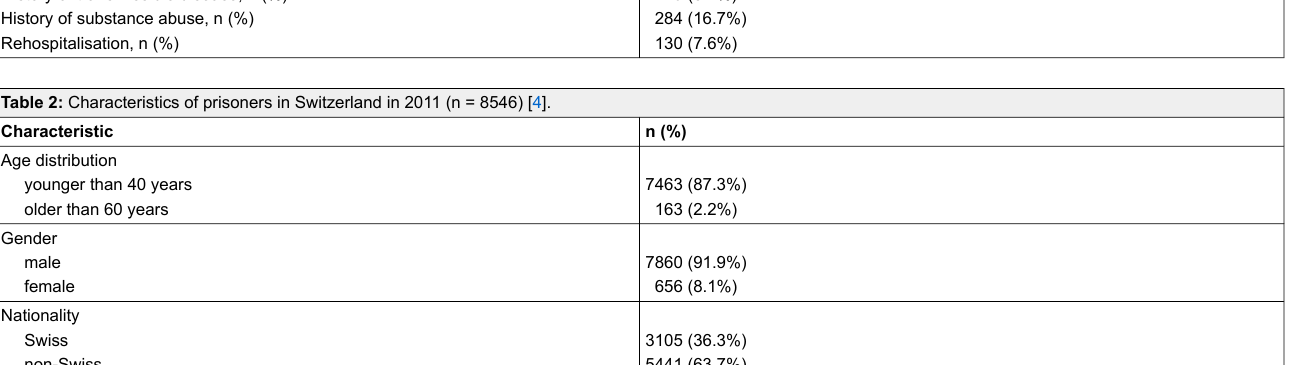
Table 2: Characteristics of prisoners in Switzerland in 2011 (n = 8546) [4]. Characteristic n